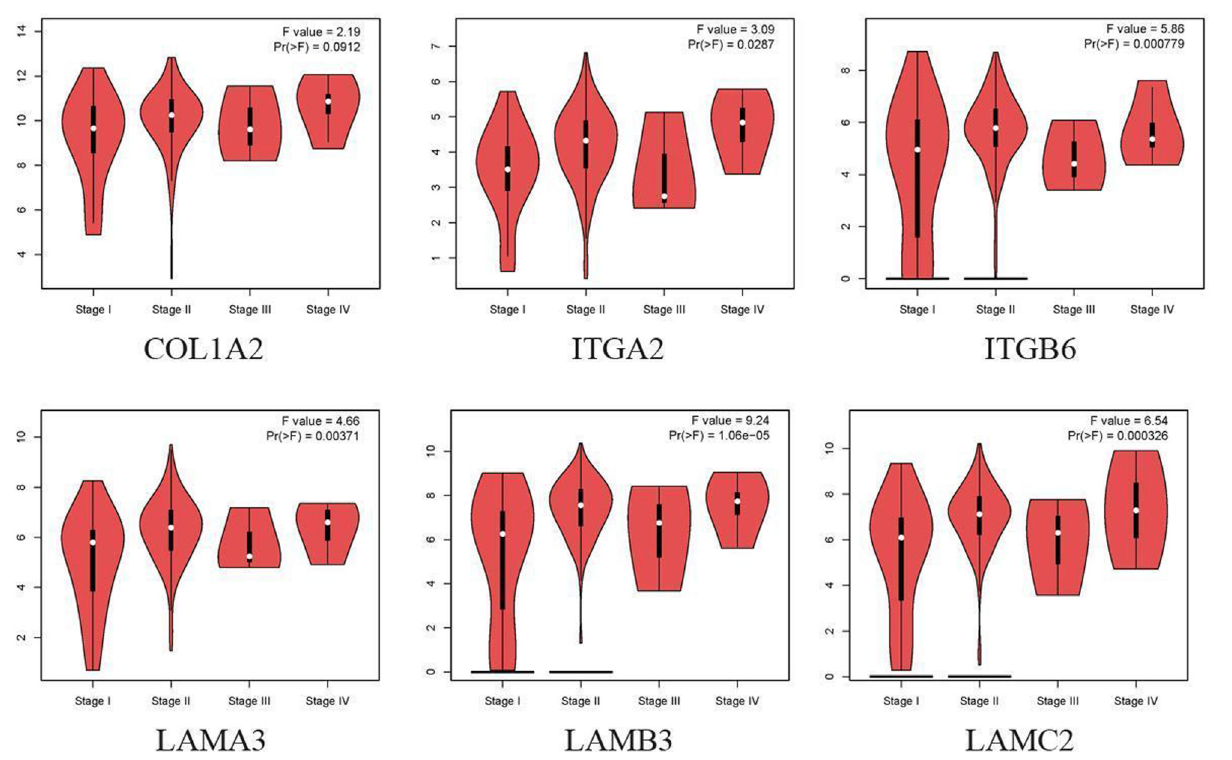
FIGURE 3 | Correlation between OS-related gene expression and tumor stage in PAAD patients